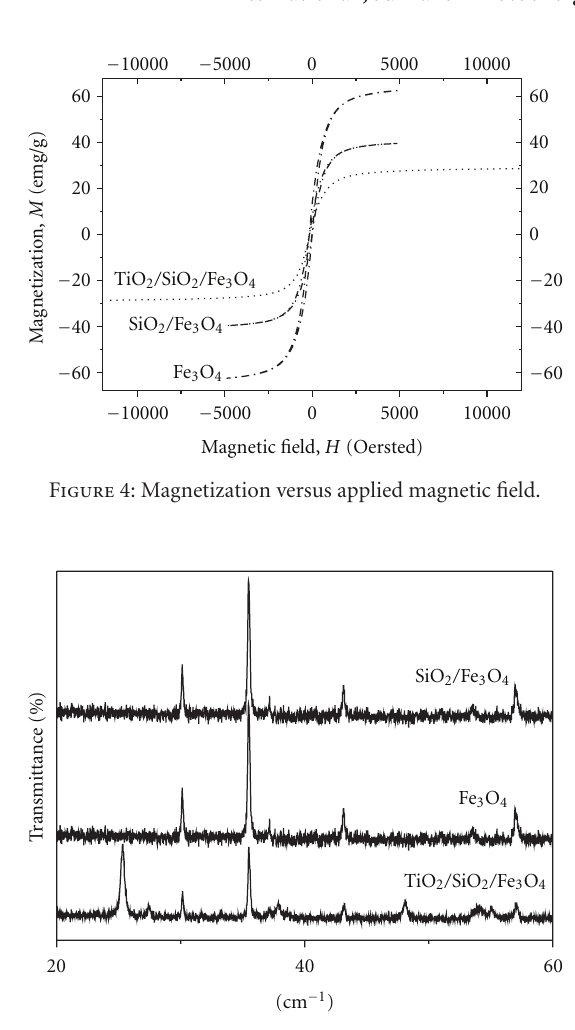
Figure 5: XRD spectra of the photocatalyst